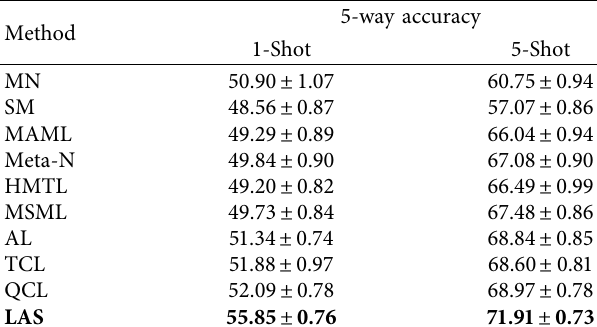
Table 1: Mean accuracy (%) ± CIs (%) of our LAS method in six cases on CIFAR-100 dataset.